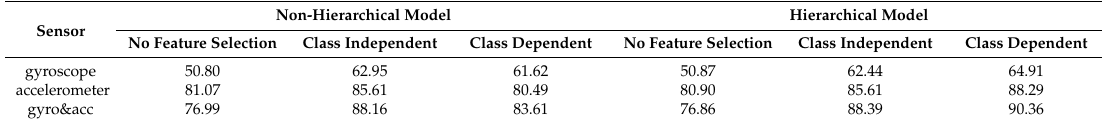
Table 5. A comparison of accuracy between hierarchical and non-hierarchical methods.